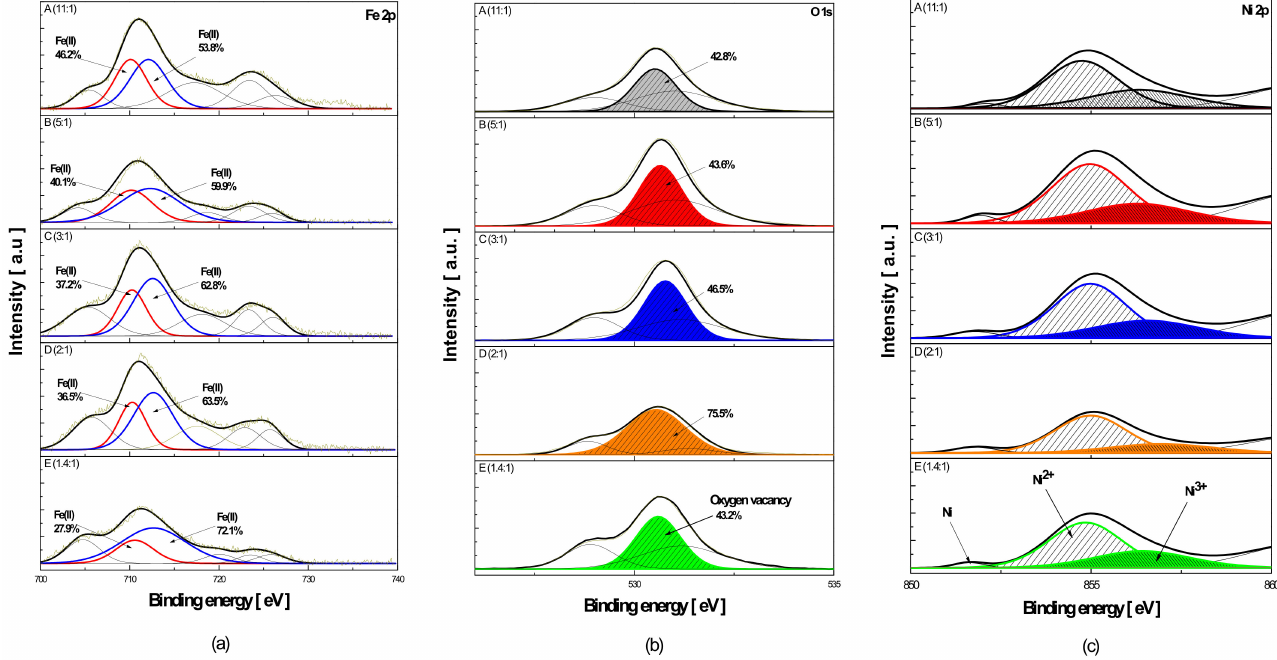
Figure 11. XPS spectra of Ni–Zn–Fe electrode after dealloying according to the different Ni:Fe ratio of the bath (A), (B), (C), (D), (E): ( a ) Fe 2p peaks; ( b ) O 1s peaks; ( c ) Ni 2p